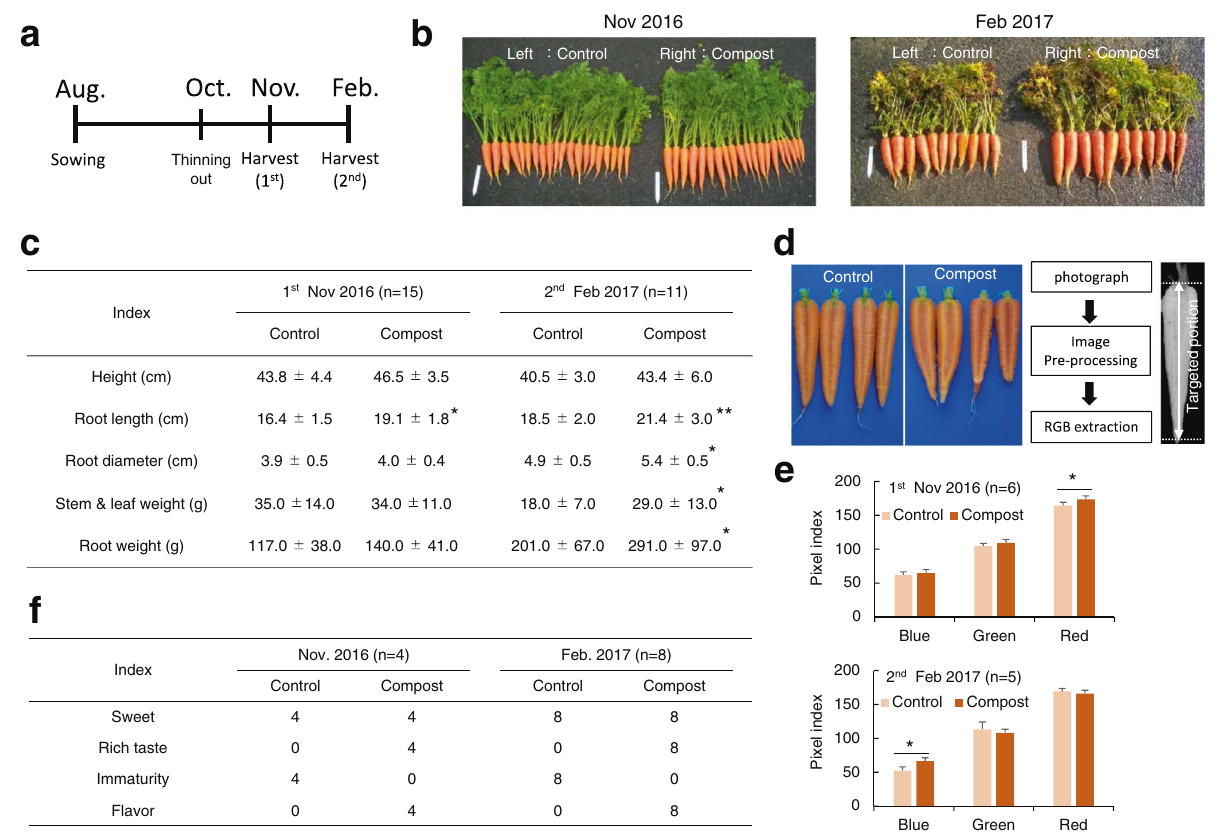
Fig. 2 Cultivation overview. a Cultivation schedule. b Photo graph of harvested carrots. c Evaluated growth indices of carrots. Fresh weights are shown. d The procedure for color assessment. e Values of RGB pixel indices in the tested carrots ( n = 6, those randomly harvested in November 2016; n = 5, those randomly in February 2017). f Results of taste evaluation. Four evaluators participated in November and eight ones in February. The asterisks are as follows: * p < 0.05; ** p < randomly sampled carrots showed that the rate of red coloration was signi fi cantly increased in November by compost amendment ( p = 0.012) (Fig. 1e). The samples in February showed that the red color in the compost-amended group appeared visually to be accentuated, but the RGB color analysis revealed that the blue coloration rate increased signi fi cantly in February by the amend- means ± SDs. Detailed testing methods not listed here are ment ( p = 0.031) (Fig. 2e). Furthermore, a taste survey indicated described in the Supplementary Methods. apparent differences in fl avor richness and immaturity. These